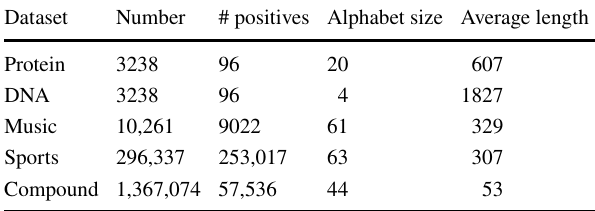
Table 2 Summary of